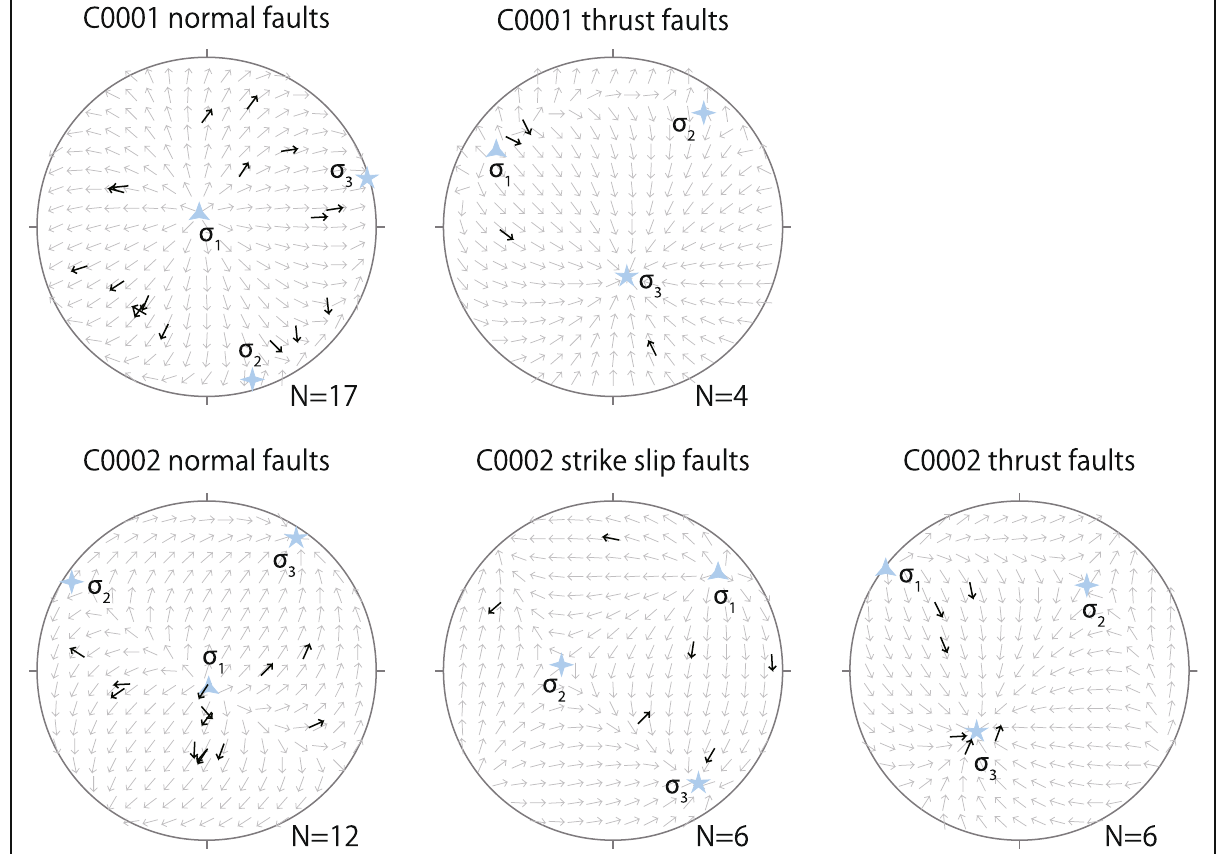
Fig. 2 Tangent-lineation plots of core-scale faults shown in lower hemisphere, equal-area projections for each fault type. The center of each arrow indicates the pole to a fault plane, and the black arrow represents the slip direction of the footwall relative to the hanging wall; thus, arrows directed inward toward the center indicate reverse faulting and arrows directed outward toward the primitive circle indicate normal faulting. The directions of the principal stresses are shown by triangles ( σ 1 ), diamonds ( σ 2 ) and stars ( σ 3 ). Gray arrows are model tangent lineations for model faults of the best-fitting inverted stress